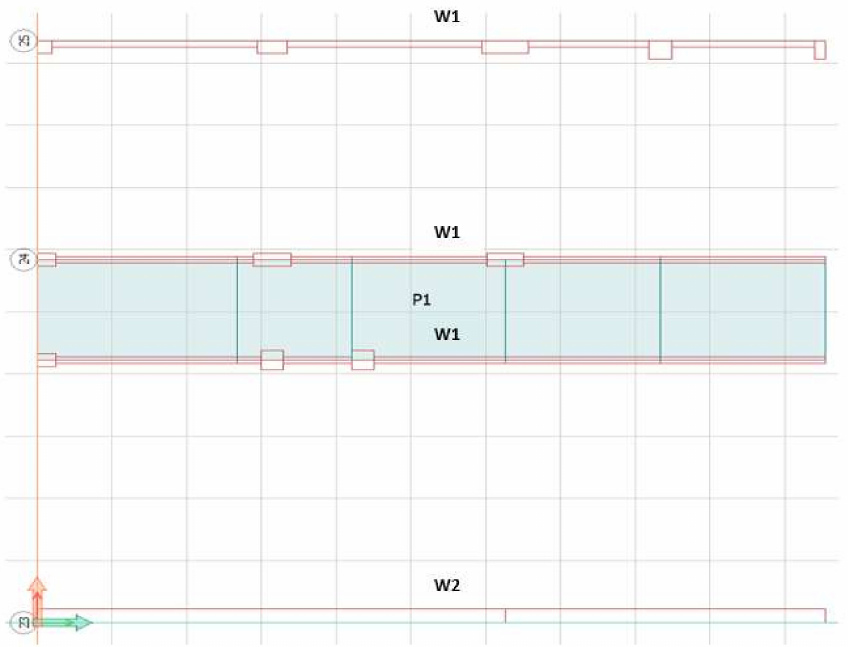
Figure 6. Floor plan of basement with named load-bearing elements.